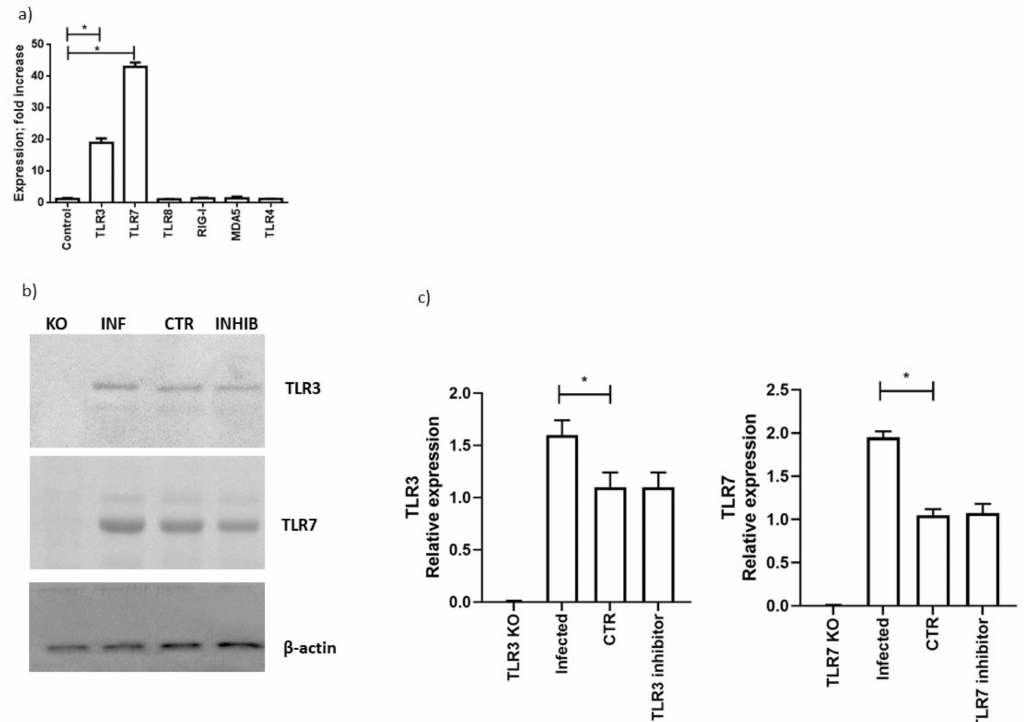
Figure 2. ( a ) Calu-3/MRC-5 multicellular spheroids were infected with SARS-CoV-2 at a multiplicity of infection (MOI) of 1.0 for 1 h at 37 ◦ C. Thereafter, the cells were washed and cultured for 48 h. Levels of expression, quantified as fold increase in comparison with uninfected cells of TLR3, TLR7, TLR8, RIG-1, MAD5 and TLR4 are reported and are representative of three independent experiments. ( b ) Western blot analysis of TLR3, TLR7 and β -actin protein expression in Calu-3/MRC-5 multicellular spheroids (CTR), silenced for TLR3 (TLR3 KO), TLR7 (TLR7 KO) with RNA silencing technology; infected with SARS-CoV-2 with at a multiplicity of infection (MOI) of 1.0 (INF: infected) and treated with TLR3 or TLR7 inhibitors (INHIB: inhibitor). The molecular weights were determined by protein ladder (Bio-Rad, Milan, Italy). Actin was evidenced at 44 kDa, TLR3 and TLR7 at 116 kDa. The images were acquired by Geliance 600 (Perkin Elmer, Milan, Italy). The complete Western blots are reported in Supplementary Figure S2. ( c ) Evaluation of protein expression by densitometry (GelDoc software; Biorad, Italy), normalized on β -actin content. Data are representative of three independent experiments. Data correspond to the mean +/ − standard deviation. * p value < 0.05, calculated with Student’s t